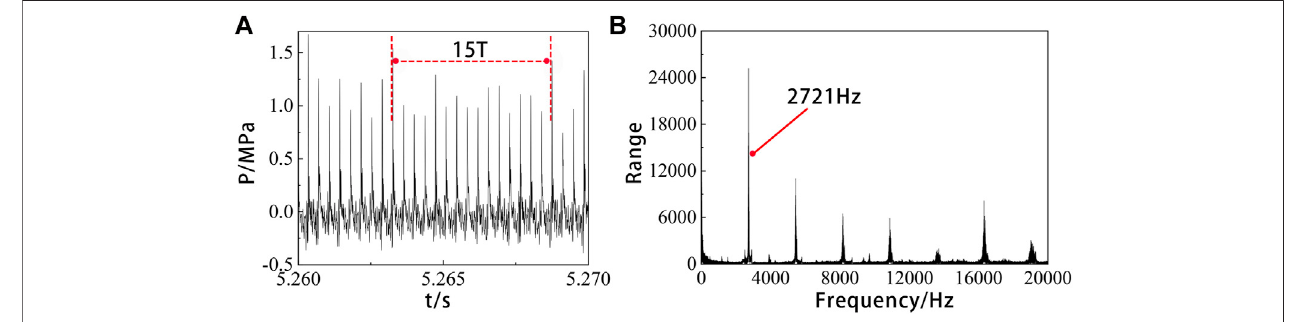
FIGURE8| Local segmentation ofthepressuresignals inthequenching stage.